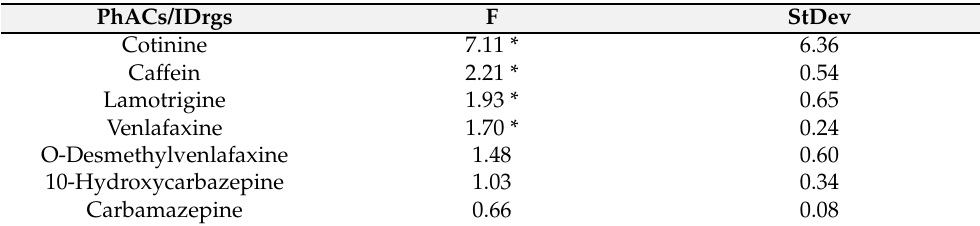
Table 3. Loss in PhACs/IDrgs mass flows in Drava River during lockdowns. *—PhACs/IDrgs with F ≥